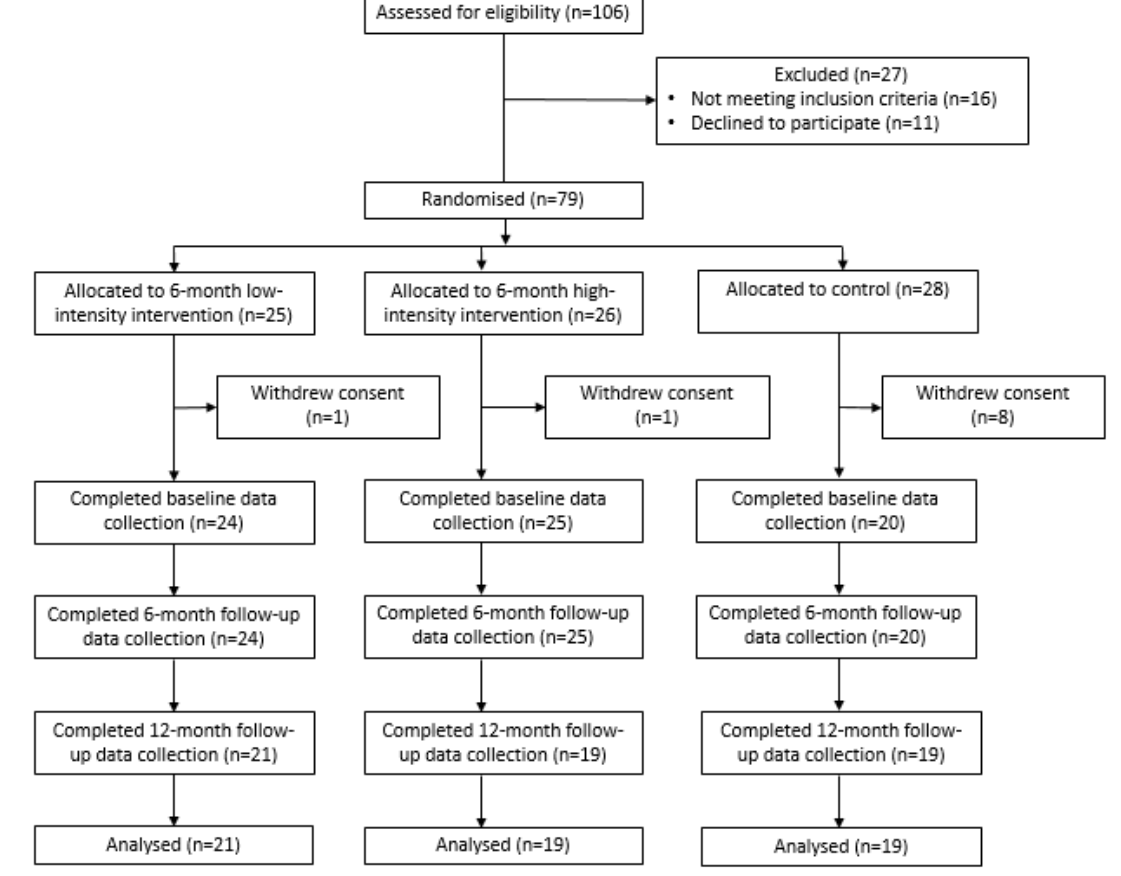
Figure 1. Study Consolidated Standards of Reporting Trials (CONSORT) flow diagram. Table 2. Baseline characteristics of participating childcare services and service cooks.